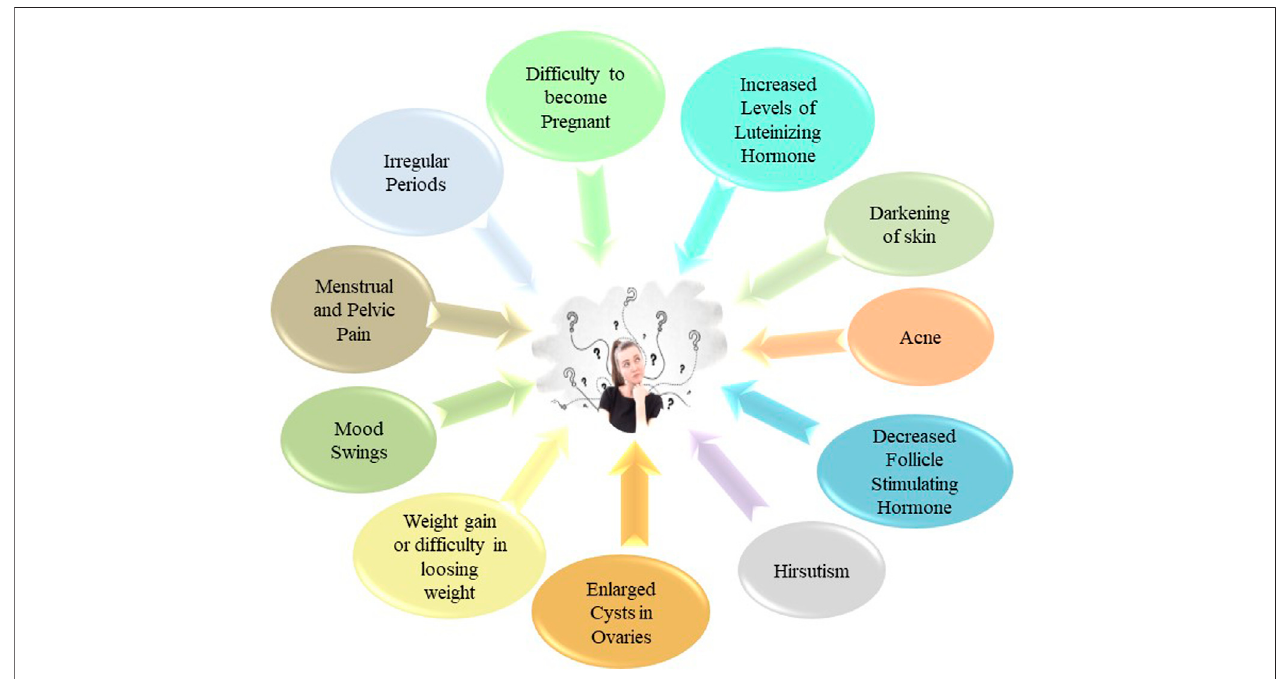
FIGURE 4 | Sign and symptoms of PCOS.